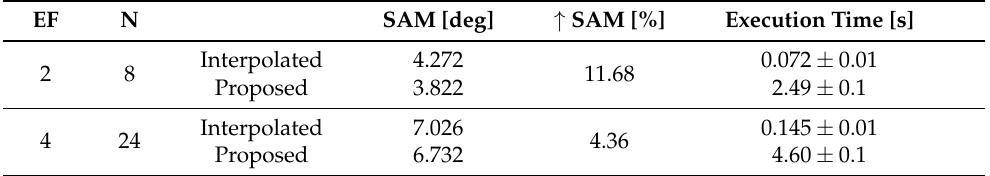
Table 1. Quantitative assessment results of the proposed SR algorithm versus interpolation for Sequence 1 . ↑ SAM represents the gain of the proposed algorithm in SAM with respect to a BI. Five executions of the same program have been carried out to confirm the execution